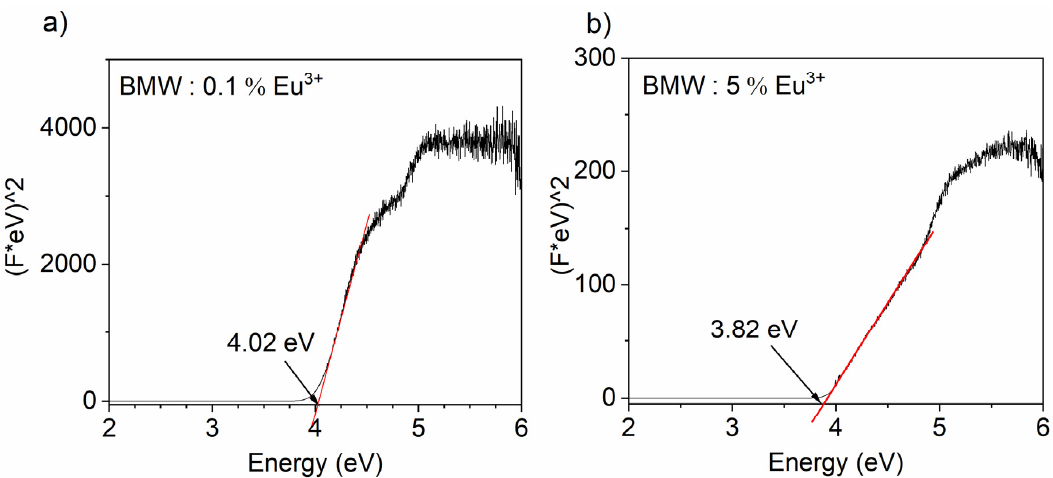
Figure 7. Forbidden energy band-gaps (E g ) of Ba 2 MgWO 6 : x Eu 3 + , ( a ) x = 0.1%; ( b ) x = 5%) calculated from the absorption spectra.